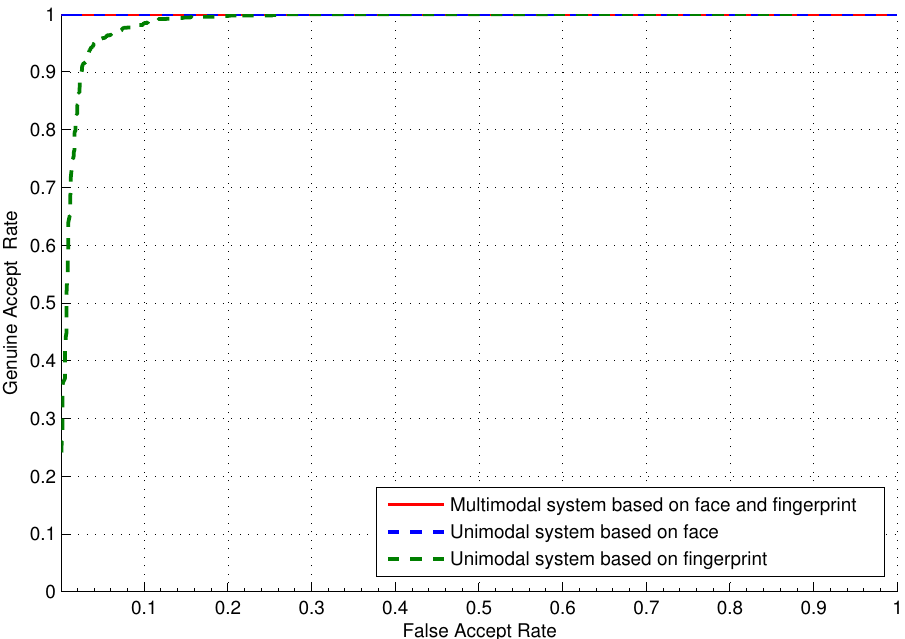
Figure 5. The ROC curve of the proposed cancelable